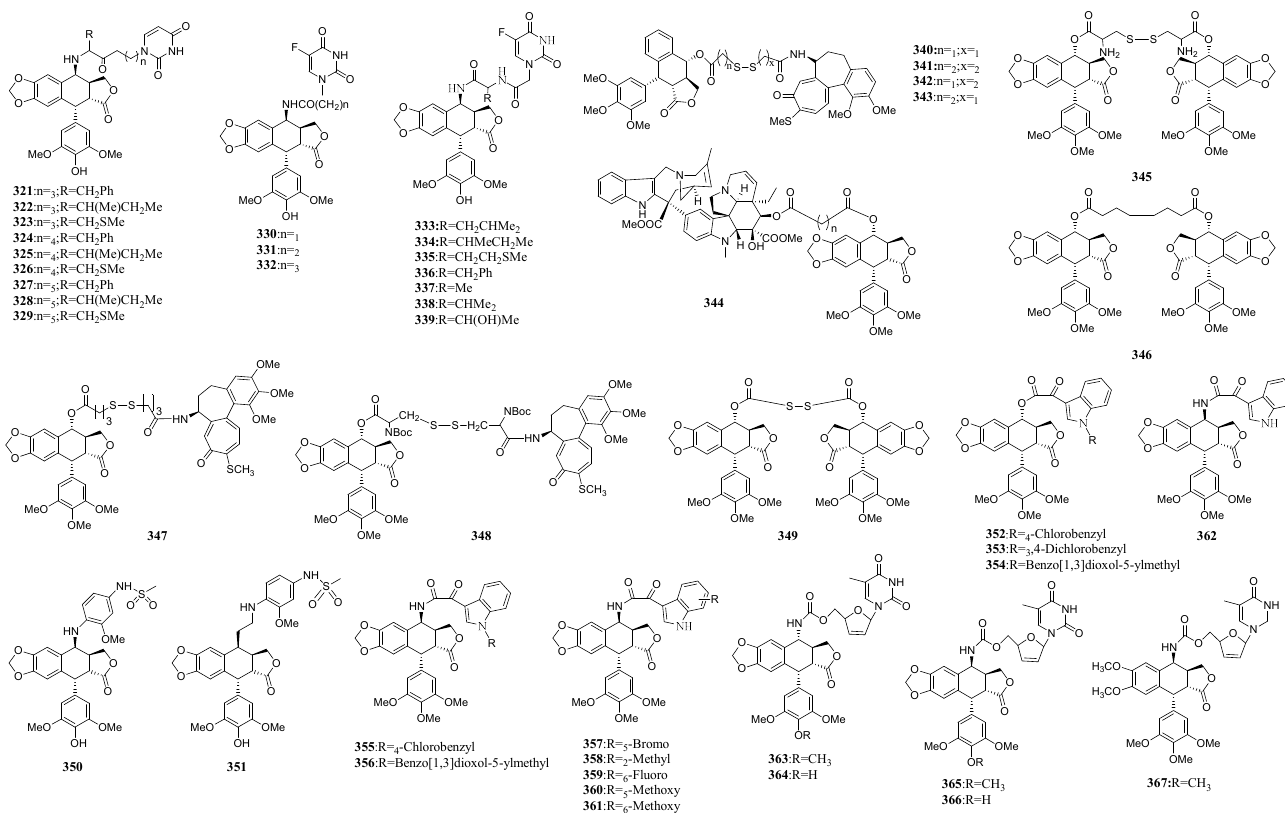
Figure 10. Conjugates containing podophyllotoxins.